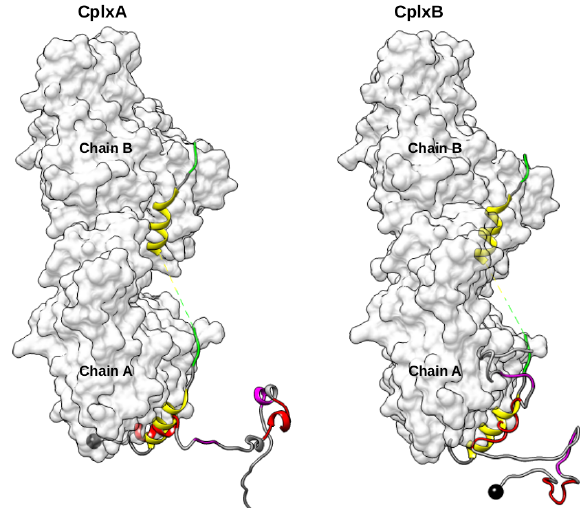
Figure 11. Side view of the two best 2:1 actin–domain V encounter complexes with N-WASP segment 9–18 ( left ) or 37–46 ( right ) located and oriented as in structure 3M3N. Black balls are N-terminal C α -atoms of domain V. Red and magenta ribbons represent its regions 9–18 or 37–46 and consensus sequences “LKKV”, respectively. As a reference, yellow and green ribbons indicate the helical and LKKV regions of domain V in